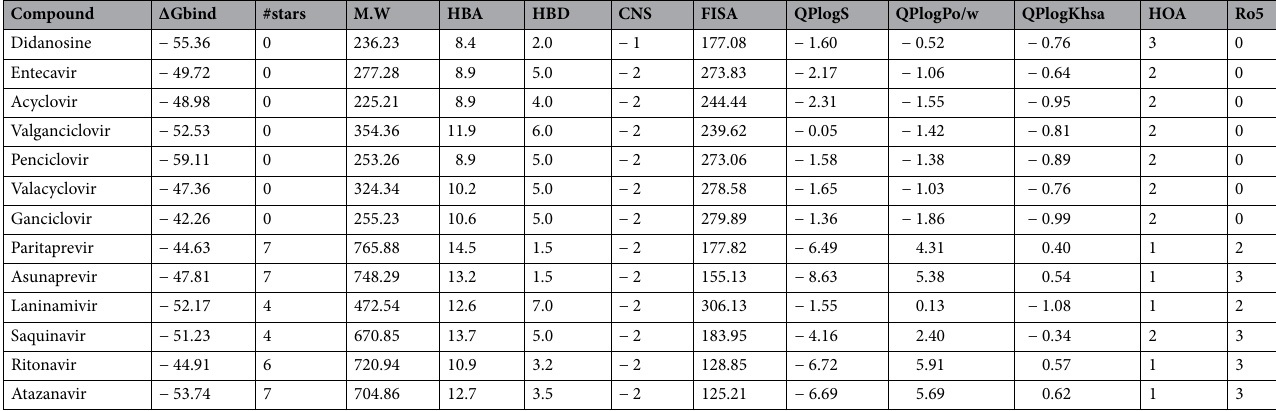
Table 1. QikProp values of 13 ligands and their ΔG bind (MM-GBSA) in PARP.